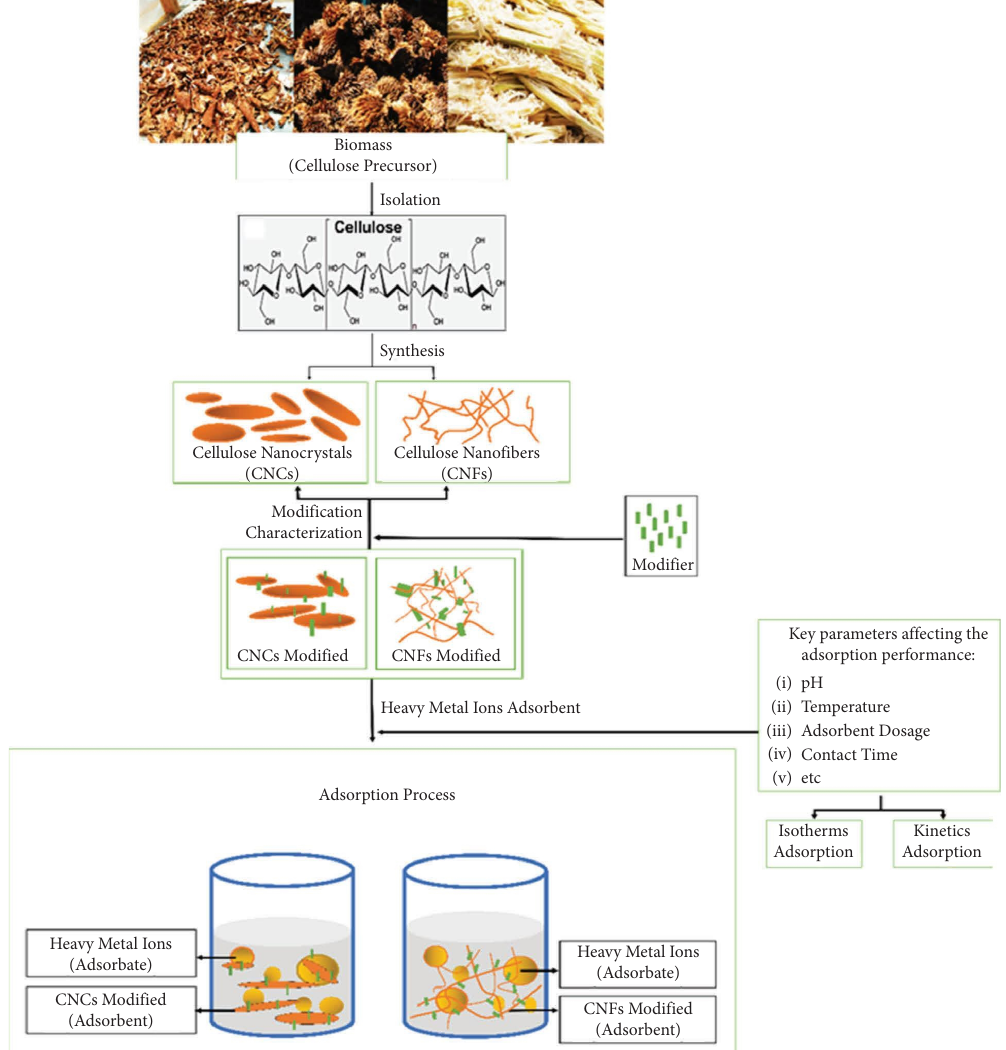
Figure 1: Summary of the review article